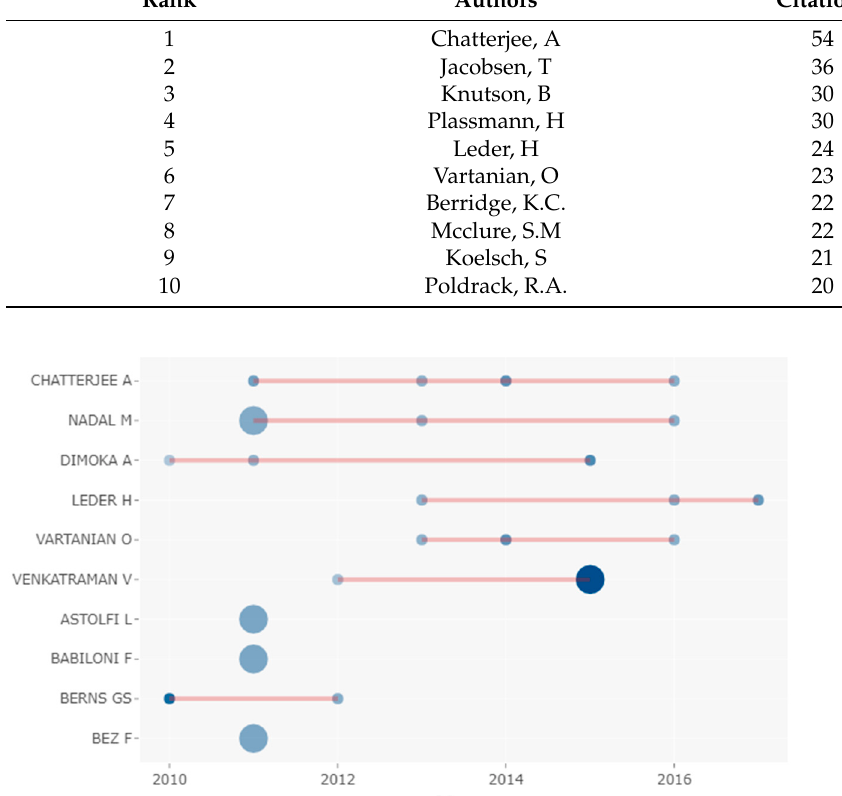
Figure 4. Top 10 Authors’ Production Over the Time Data Visualization. The line represents the